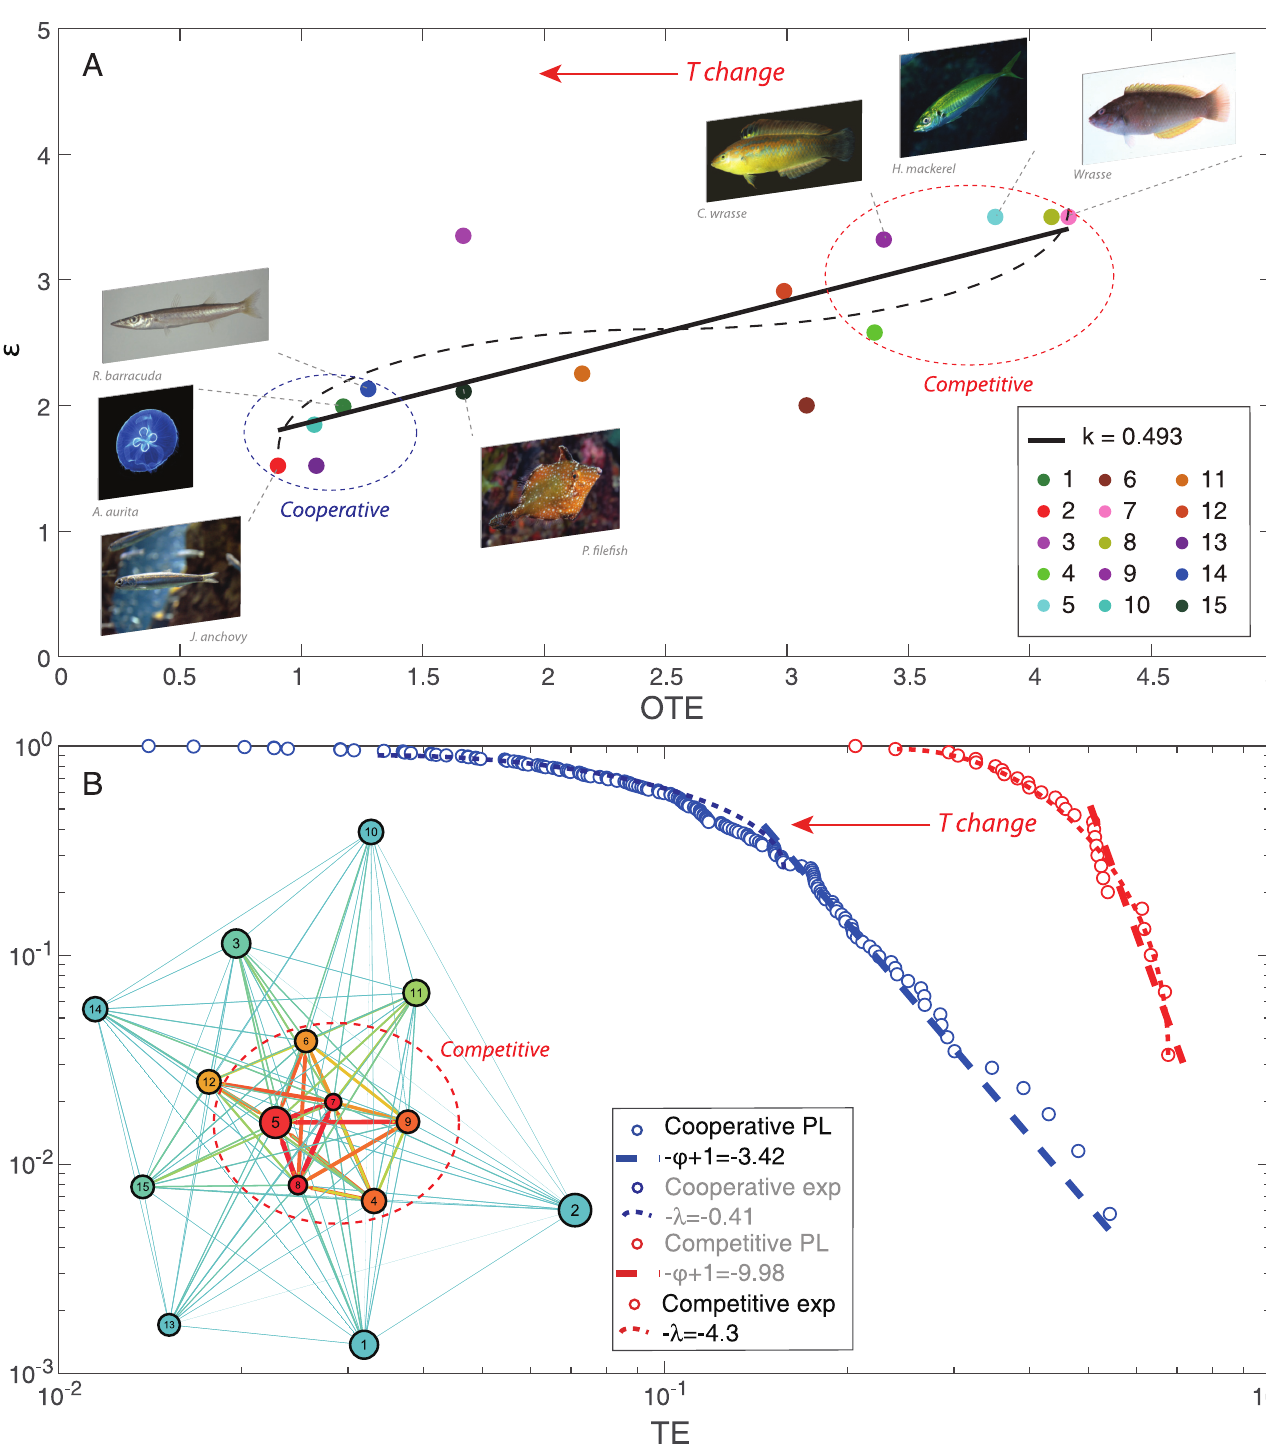
PLOS ONE | https://doi.org/10.1371/journal.pone.0246222 October 20,